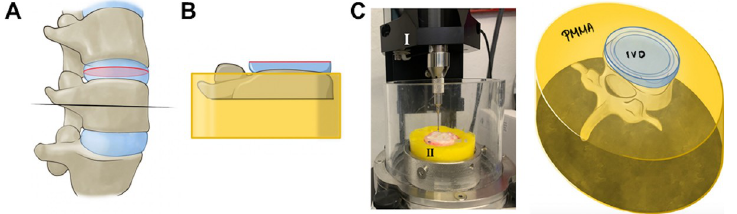
Fig 4. Biomechanical testing unit preparation for indentation analysis. A) Schematic representation of a spine segment. The black line indicates the cut made on the vertebral body. The red line indicates the cut made on the middle area of the intervertebral disc. B) Biomechanical testing unit composed of half intervertebral disc with its half vertebral body. C) Biomechanical indentation device (I). The biomechanical testing unit presented in (B) was mounted on bone cement to secure stability during testing